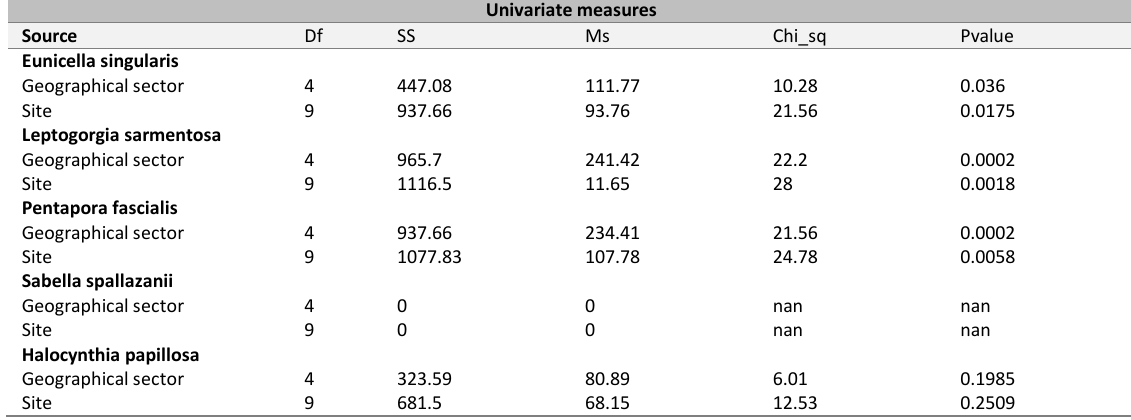
Table 7: Results of univariate Kruskall-Wallis testing the effects of geographical sector and site on the presence/absence by species. Sites tested: AGM1 vs AGM2 vs AGD2 vs AGD3 vs VLR1 vs VLR2 vs GRU1